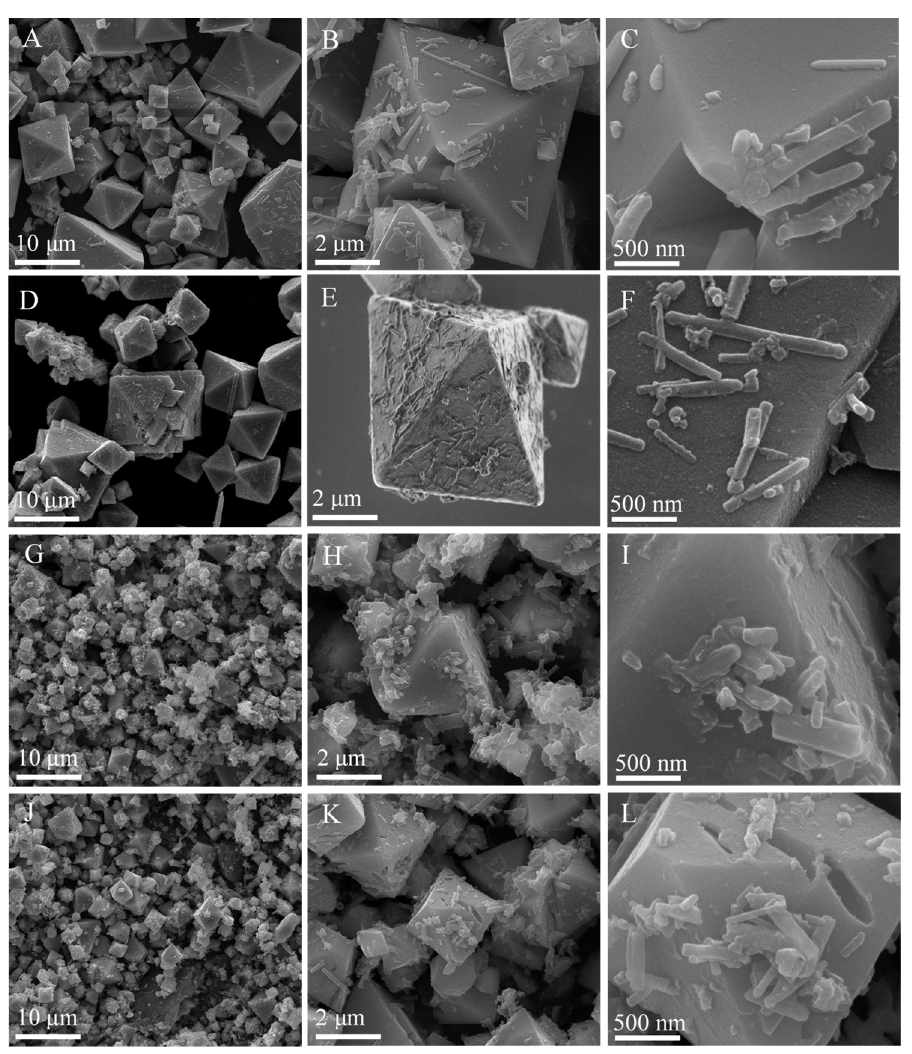
Figure 2. SEM images ofMnS treated at 423 K ( A – C ),433 K ( D – F ), 443 K ( G – I ), and 453 K ( J – L